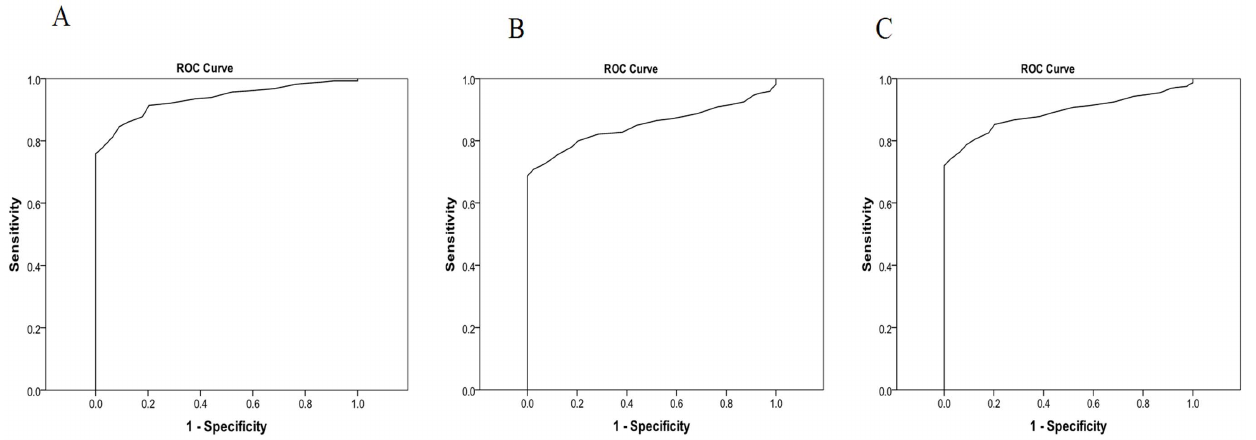
Figure 4. Receiver operator characteristic curves to identify mutation patients with a GCK mutation from those with type 1 or type 2 diabetes using HbA1c. (A) mutation carrying patients from those with type 1 diabetes AUC 0.94 (B) mutation carrying patients from those with type 2 diabetes AUC 0.86 and (C) mutation carrying patients from those with type 1 or type 2 diabetes (types combined) AUC 0.89.